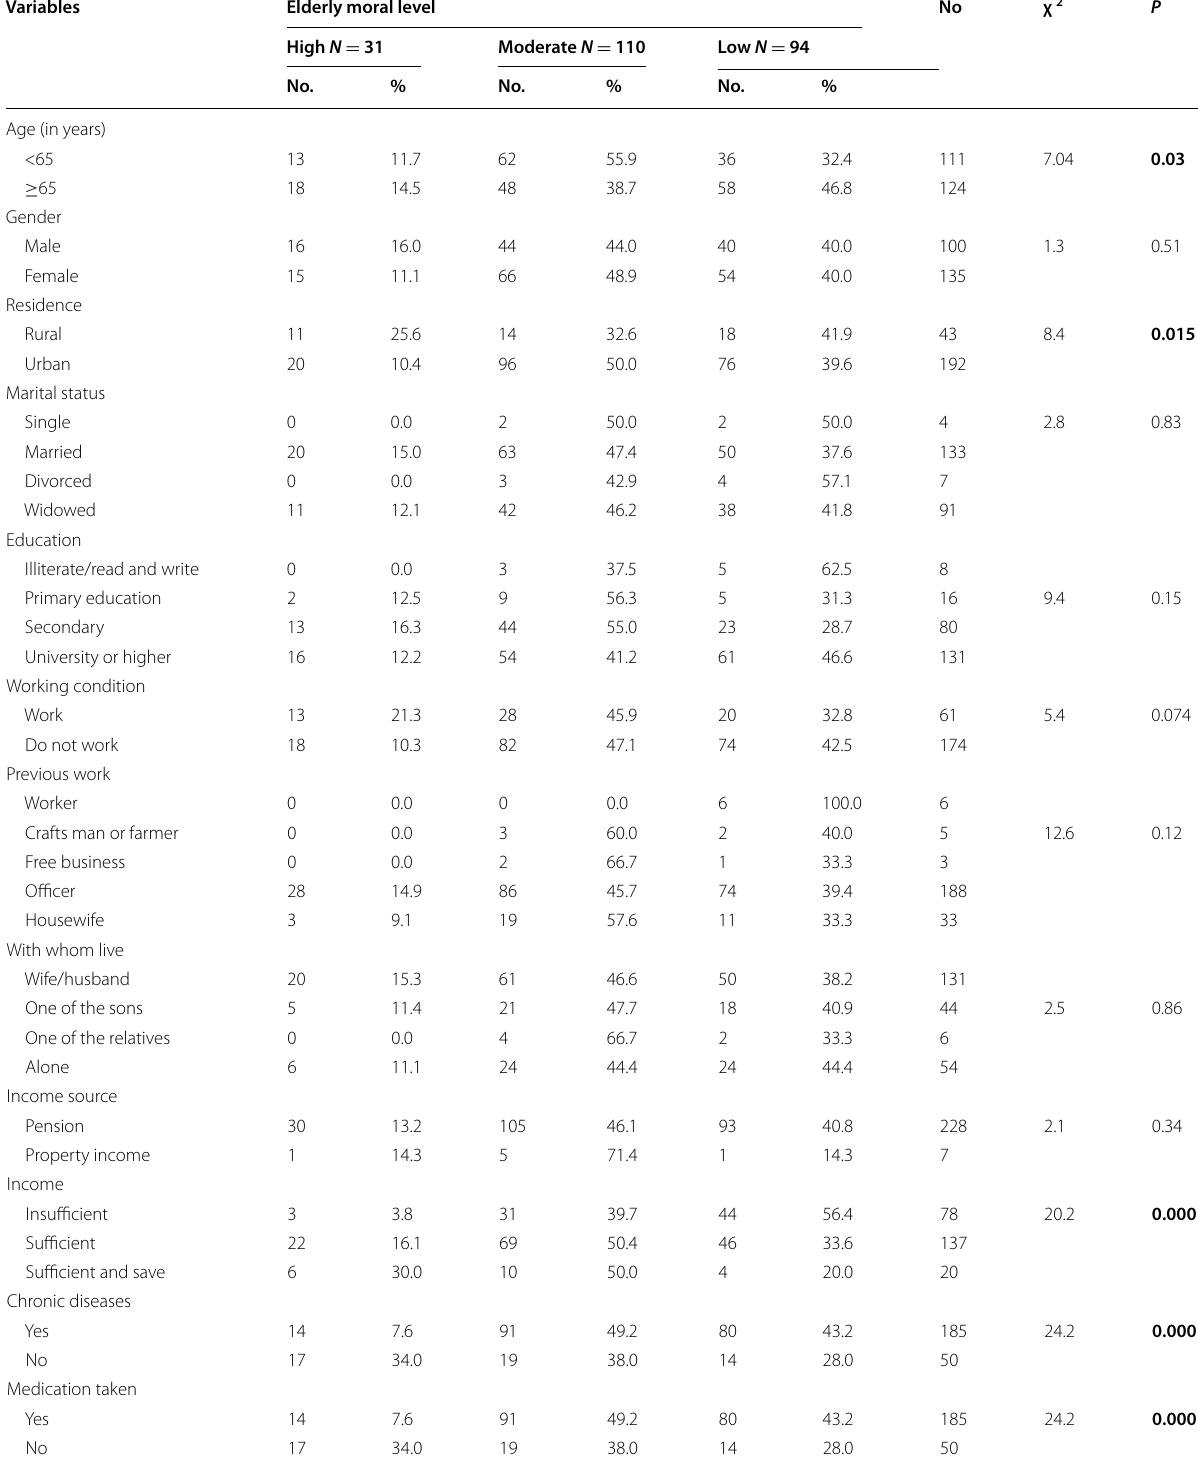
Table 4 Relations between morale level and socio-demographic characteristics of studied elderly ( n